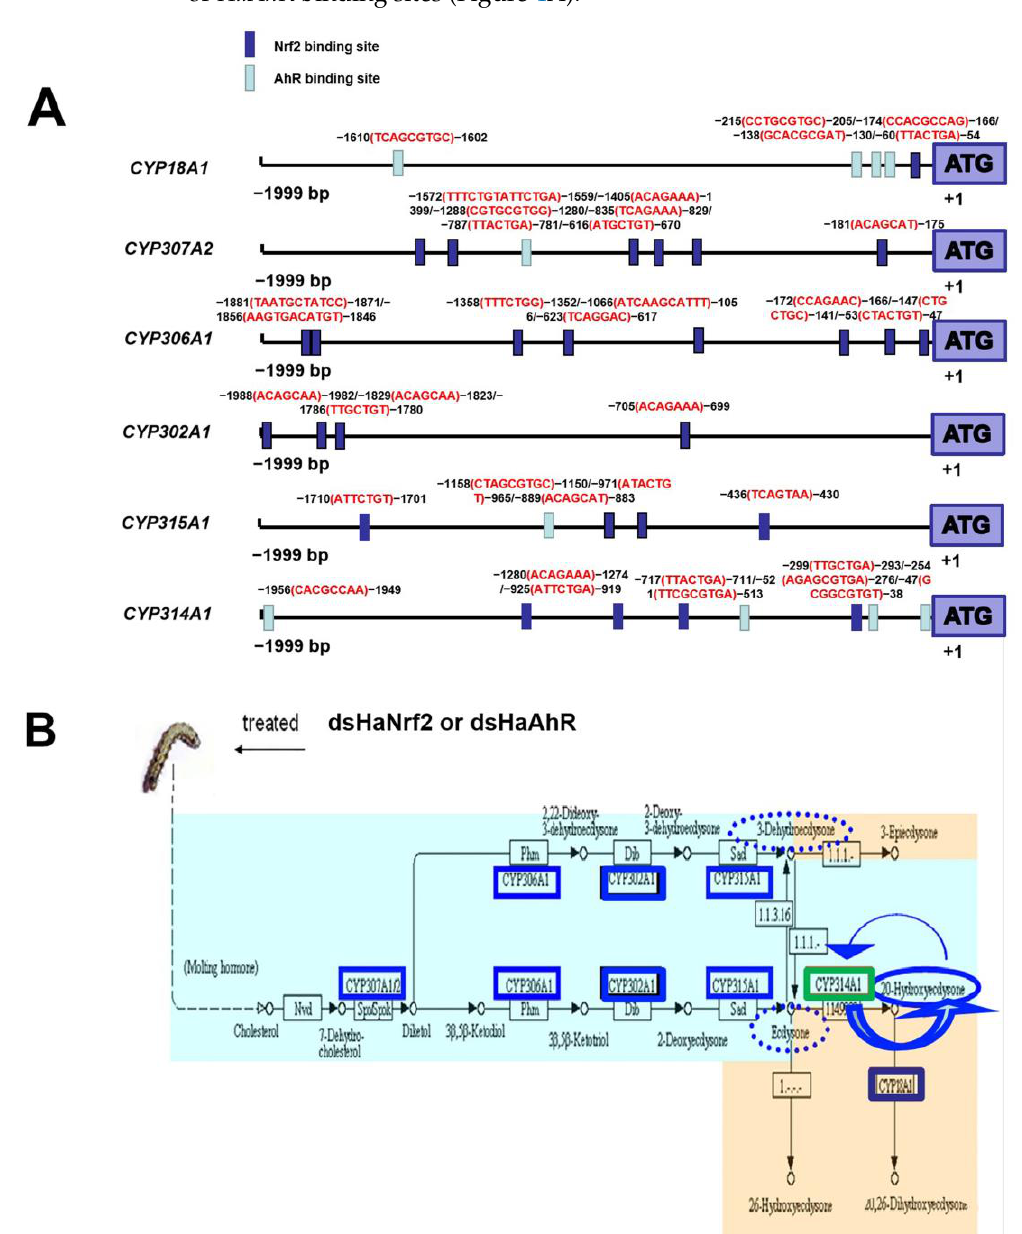
Figure 4. RNAi HaNrf2 and HaAhR affects the biosynthesis and metabolism of insect hormones. ( A ) Analysis of genes’ promoter regions was performed to identify possible regulatory elements. Antioxidant response element (ARE) for Nrf2 (ARE/Nrf2: TMANNRTGAYNNNGCRWWW; DMATGCTKWGT; WCAGHAW), and xenobiotic response element (XRE) from the aryl hydrocarbon receptor (XRE/AhR: TNGCGTG; NCACGCNNN; GAKKTGCGTGASAAGAG; MRGSYTCTTCTCACGCAACTCC; KYKKCTCACGCWRYW; DCACGCAASKCHSAAW; CACGTGCAA). Element position “+1” is defined relative to the start codon ATG. ( B ) RNAi HaNrf2 and HaAhR effects on the genes’ expression in synthesis pathway of insect hormone. Genes both down-regulated following treatment with dsHaNrf2 or dsHaAhR are shown with solid blue lines. Genes only down-regulated following treatment with dsHaNrf2 are shown with solid green lines.